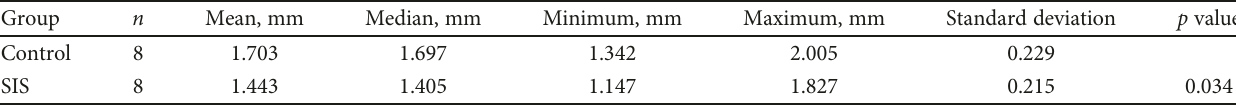
Table 1: Tracheal defect perimeter: comparison between groups.